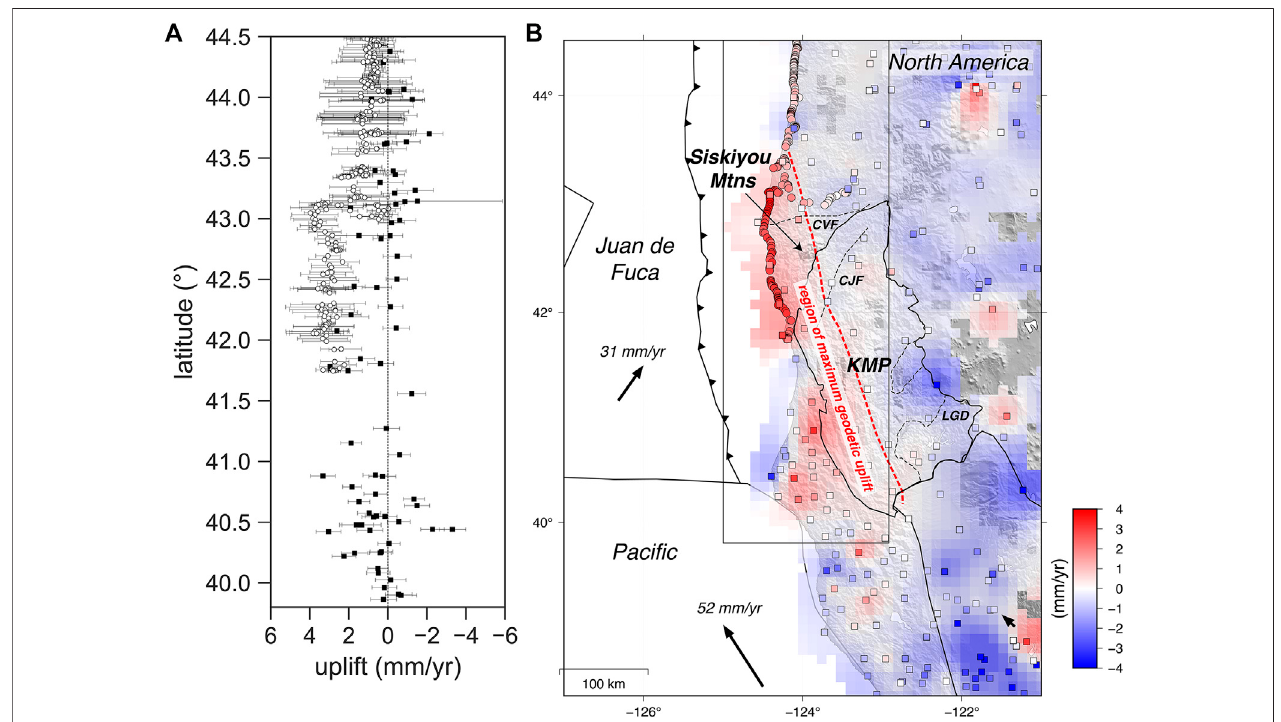
FIGURE 7 | Present-day uplift rates across the southern Cascadia forearc. (A) Graph of uplift versus latitude for GPS (black squares) and benchmark leveling data (white circles) from coastal regions in southern Cascadia (125 ° W – 123 ° W) (Burgette et al., 2009; Blewitt et al., 2018). (B) Map of present-day uplift rates. The circles are benchmark level data (Burgette et al., 2009) and the squares are GPS vertical motions (Blewitt et al., 2018). The semi-transparent interpolated uplift shown in the background is derived from a grid of the GPS vertical motions with a grid size of 10 km, and masking threshold of 30 km. The dashed red line is the approximate eastern extent of the maximum upper-plate uplift signal in the